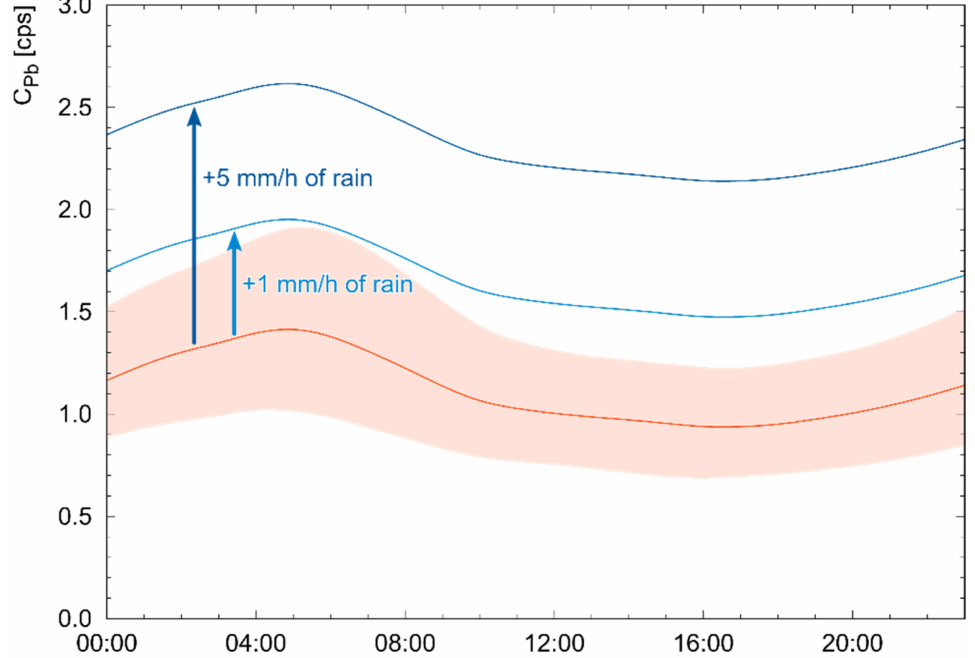
Figure 9. Diurnal oscillation of C Pb as a function of the hour of the day. For each of the 268 sunny days of the two data takings, the 15 min resolution data have been grouped in 24, 1 h temporal